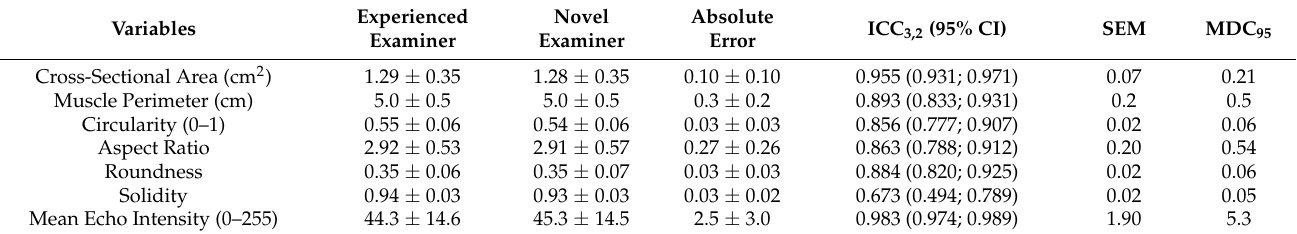
Table 2. Inter-examiner reliability for the anterior scalene US